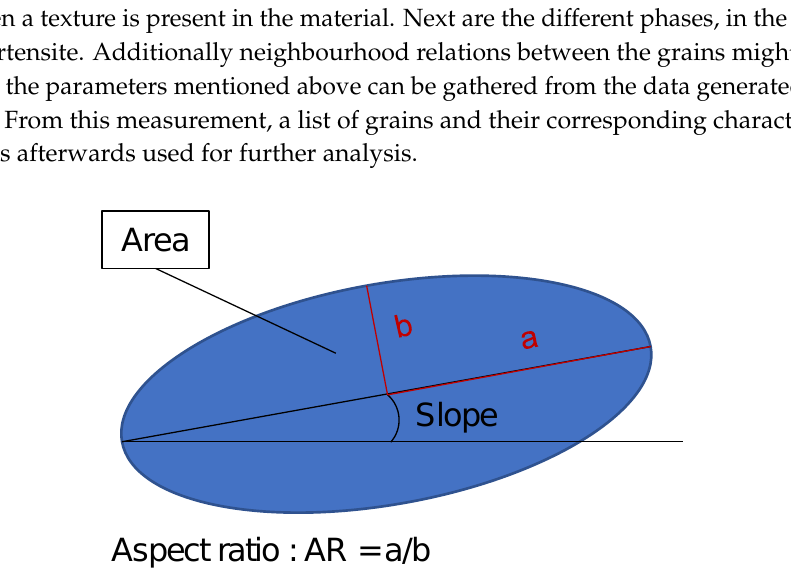
Figure 2. Schematic representation of a single grain with the associated shape